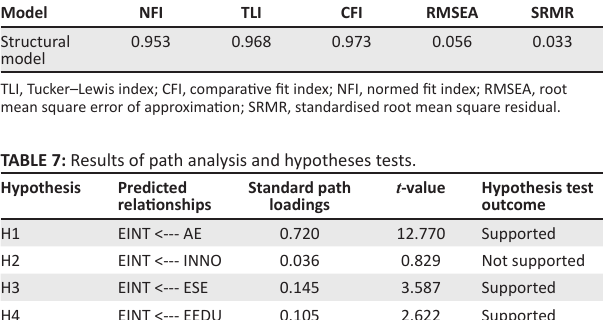
TABLE 5: Goodness-of-fit indices for the measurement model. Model